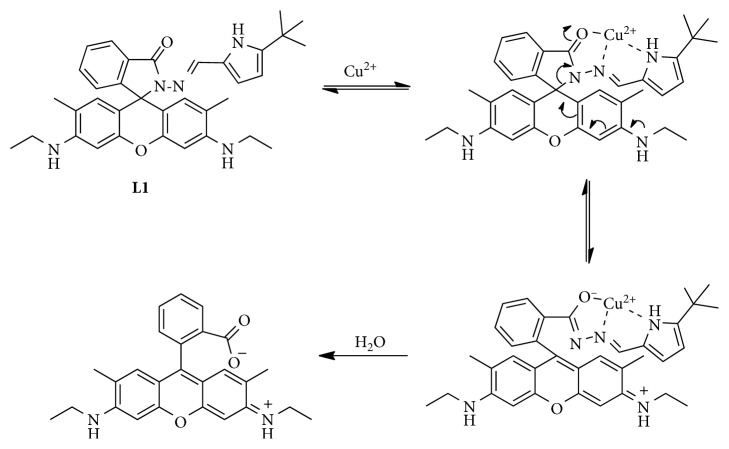
The proposed reaction mechanism of L1 with Cu2+.